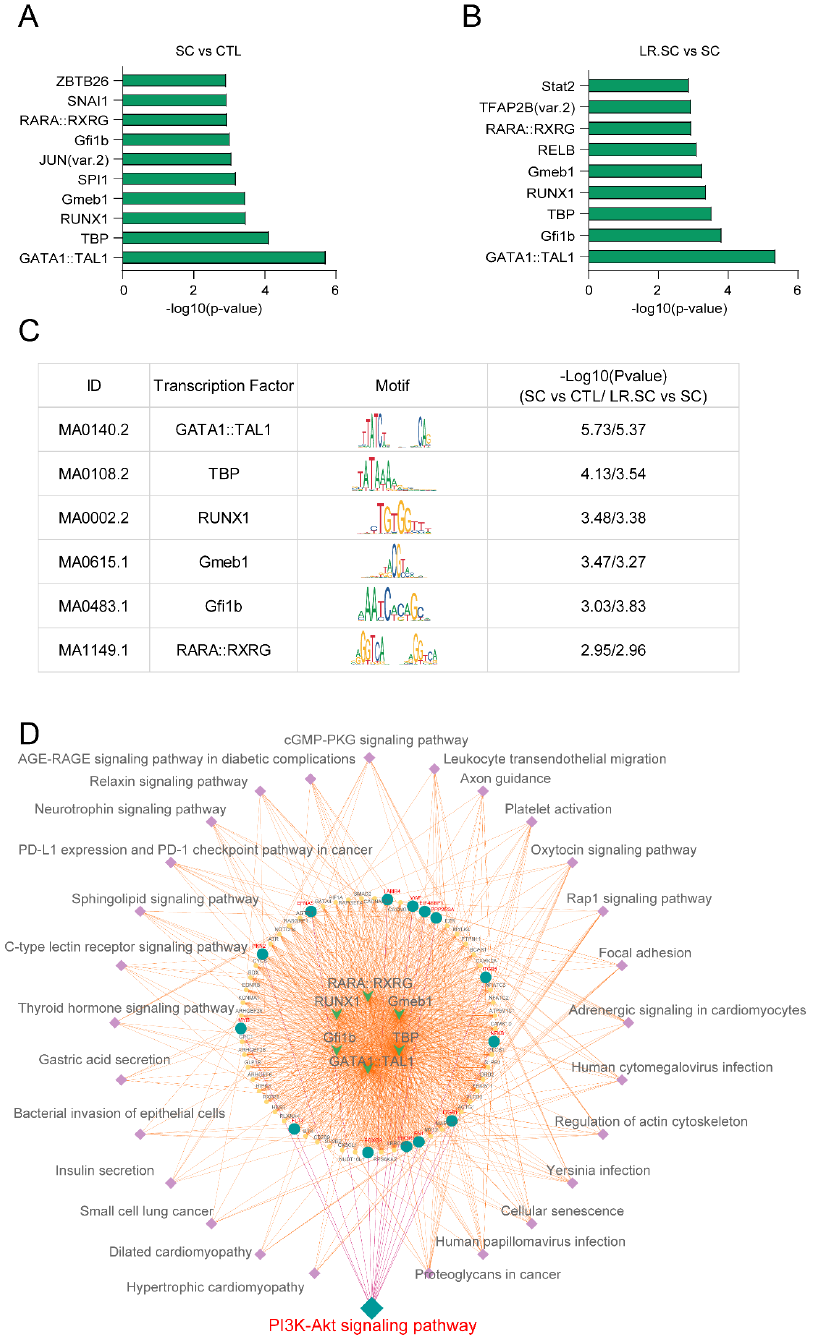
Figure 5. MEME analysis to identify functional TFs after different treatments in IPEC-J2 cells. ( A , B ). Top 10 transcription factor-binding motifs enriched in significantly increased and decreased peak regions, according to the p -values among different combinations of groups. ( C ). Common TFs and their corresponding motif details among different combinations of groups. ( D ) PPI interaction network of common TFs and genes annotated by TFs were subjected to KEGG analysis; the innermost inverted arrow shows TFs, the middle circle shows genes, the lateral square shows enriched pathways, and green circles are genes in the PI3K/AKT signaling pathway.